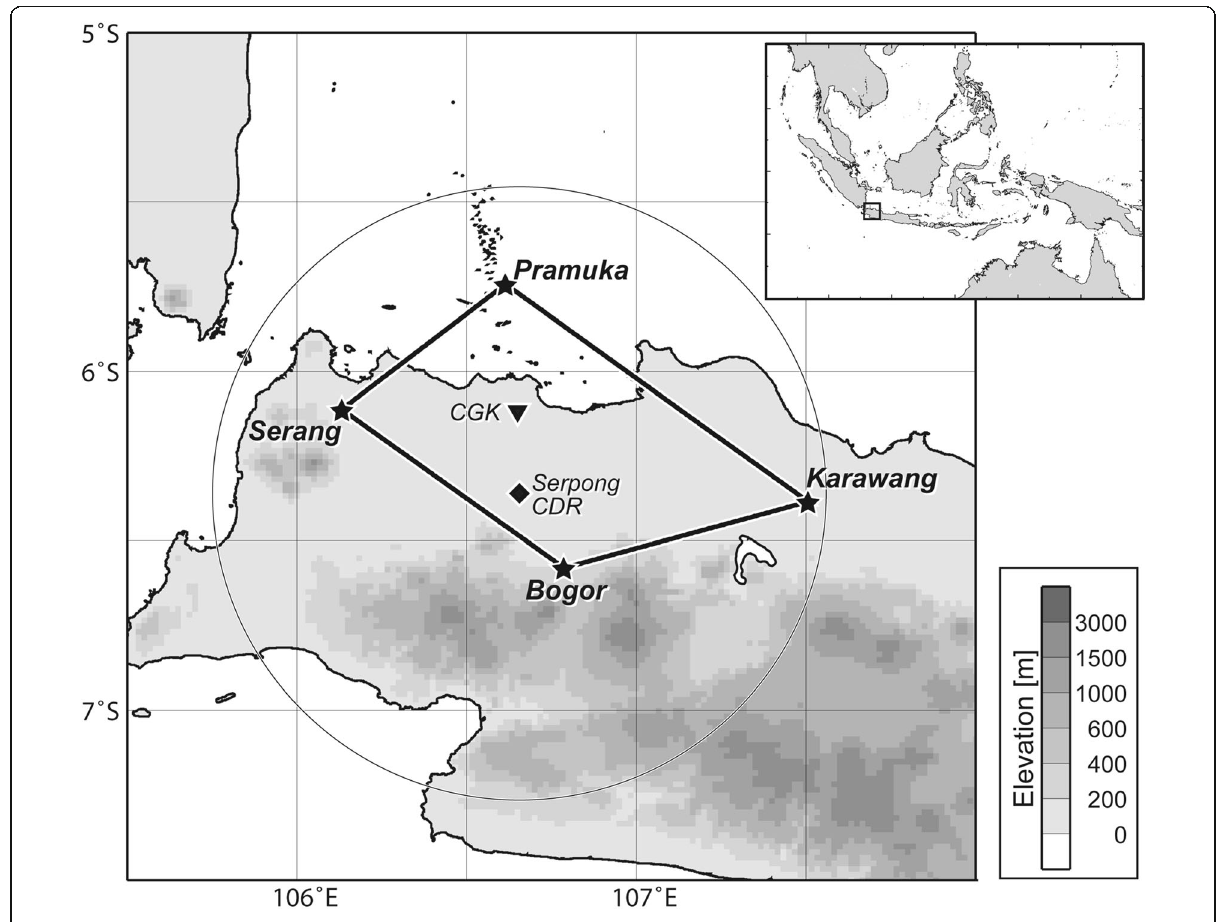
Fig. 1 Map of the HARIMAU2010 observational area. The location of the area is designated by the small square in the large-area map in the upper-right corner. The four stars indicate the sounding stations utilized in the present study. The diamond and co-axial big circle indicate the location and observational range (105 km in radius) of the C-band radar at Serpong, respectively. The inverted triangle indicates the position of the meteorological station at CGK (Soekarno-Hatta International